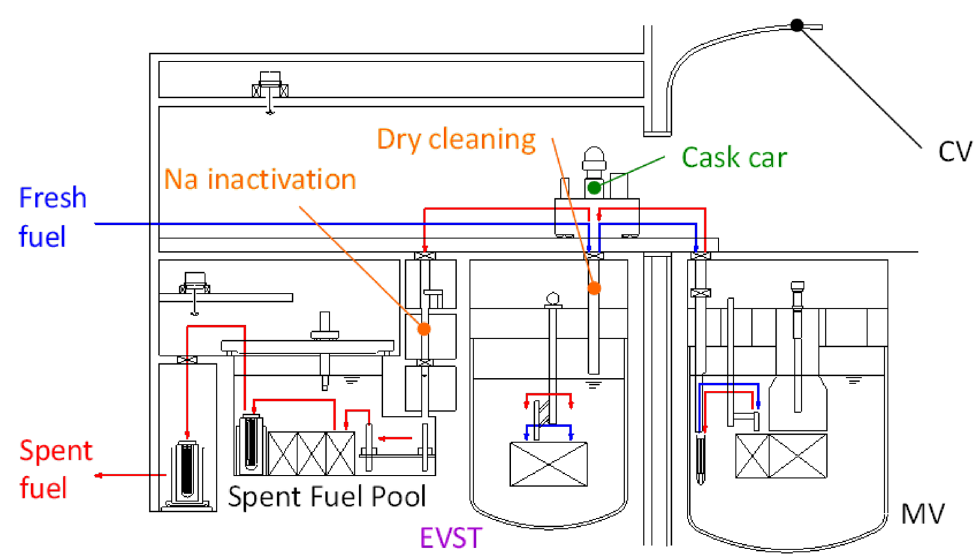
Fig. 10. FHS in Japan pool type